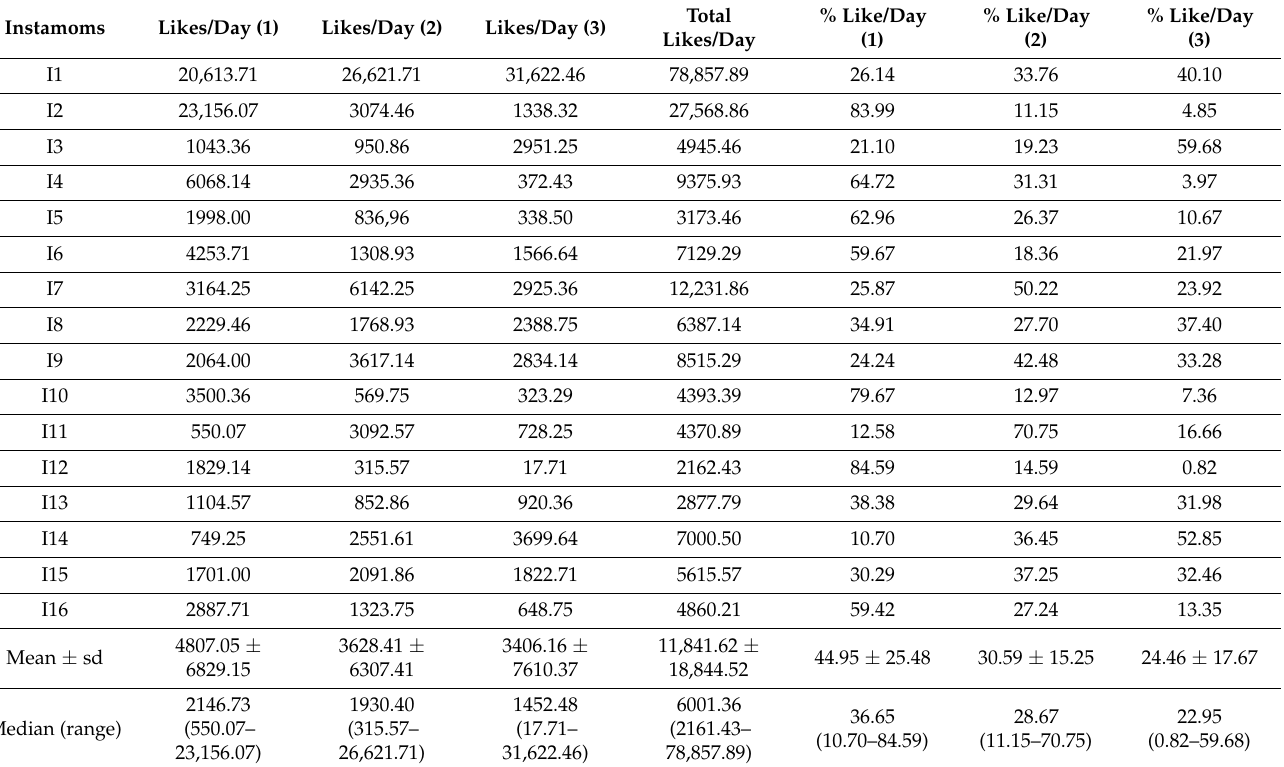
Table 2. Average number of likes/day and percentages they represent for each Instamom in each of the three analysed situations: (1) when at least one child appears, (2) when the mother appears alone, (3) when the mother appears in company of an